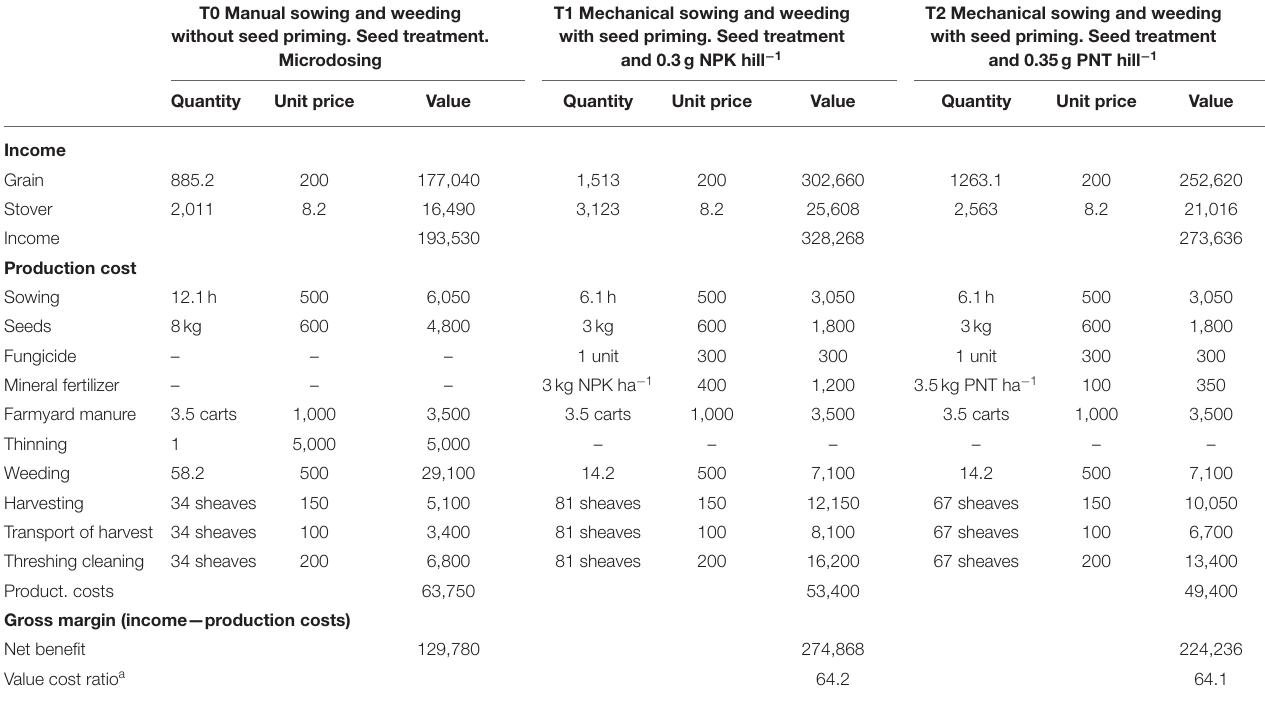
TABLE 7 | Effect of treatment on income, production cost, and gross margin (FCFA ha − 1 ). T1 Mechanical sowing and weeding T0 Manual sowing and weeding with seed priming. Seed without seed priming. Seed treatment.